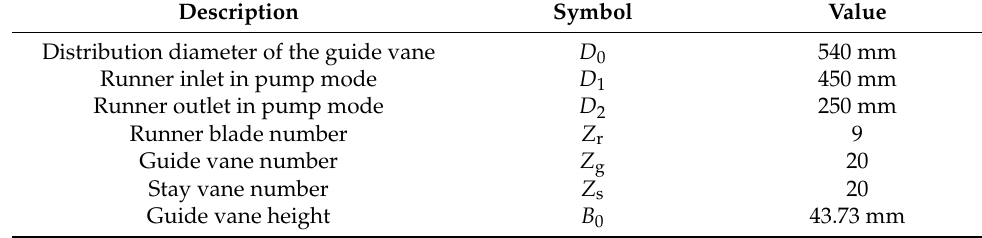
Figure 2. Description of the hump region. Table 1. Parameters of the pump turbine.